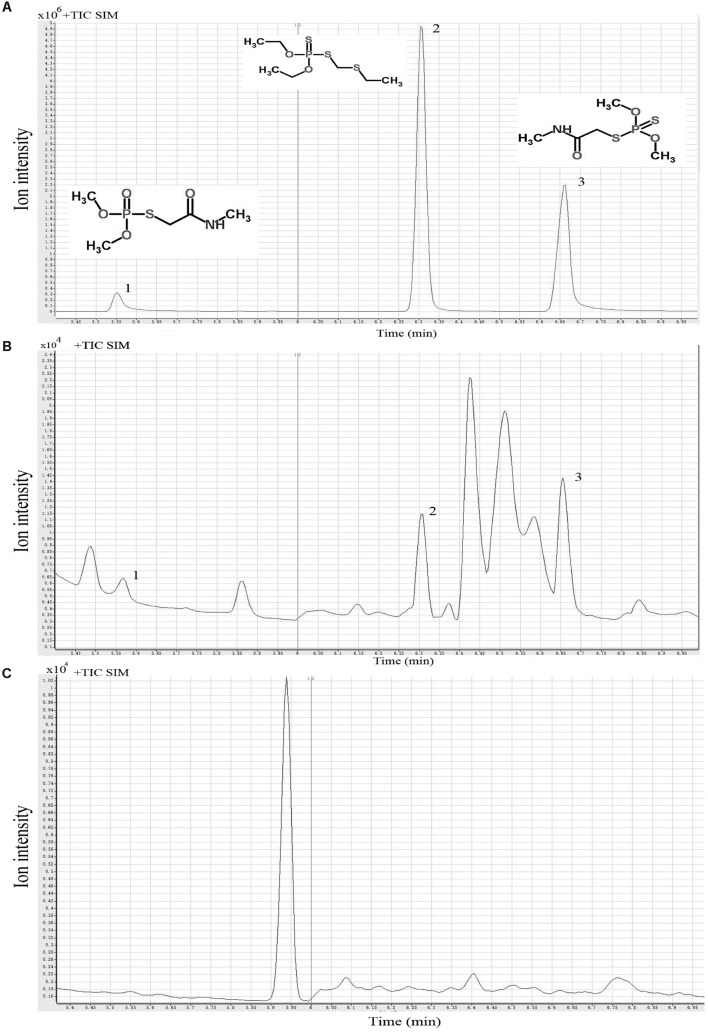
Typical single ion monitoring (SIM) gas chromatography-mass spectrometry (GC-MS) profiles of three organophosphorus pesticides. Standard solution (A), culture supernatant (B), and sonicated cell extract (C). Peaks 1-3 represent omethoate, phorate, and dimethoate, respectively.